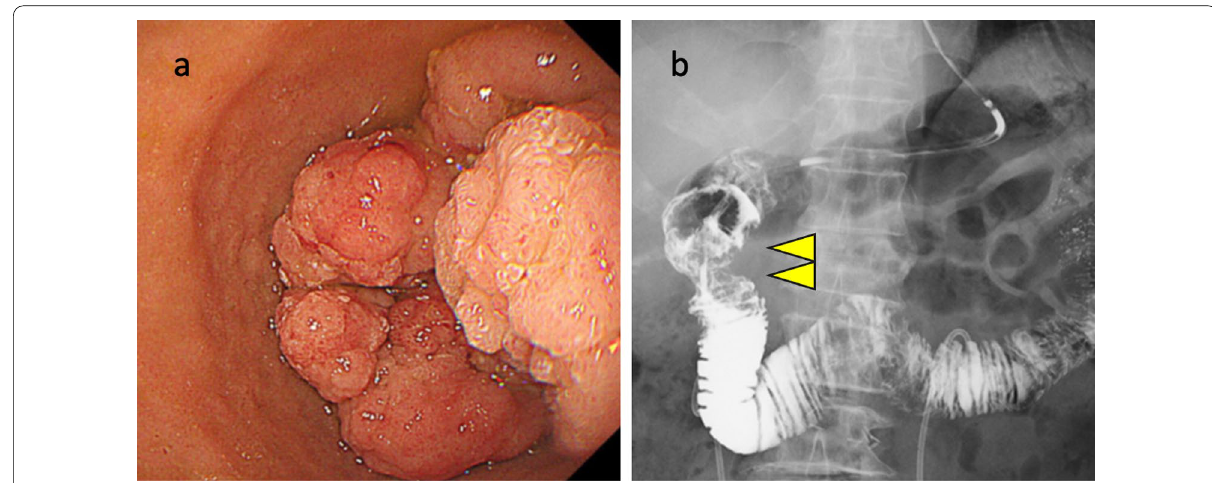
Fig. 1 a Upper gastrointestinal endoscopy revealed a circumferential papillary tumor located from the duodenal bulb to the descending duodenum. b Duodenography revealed a circumferential tumor in the supra-ampullary duodenum